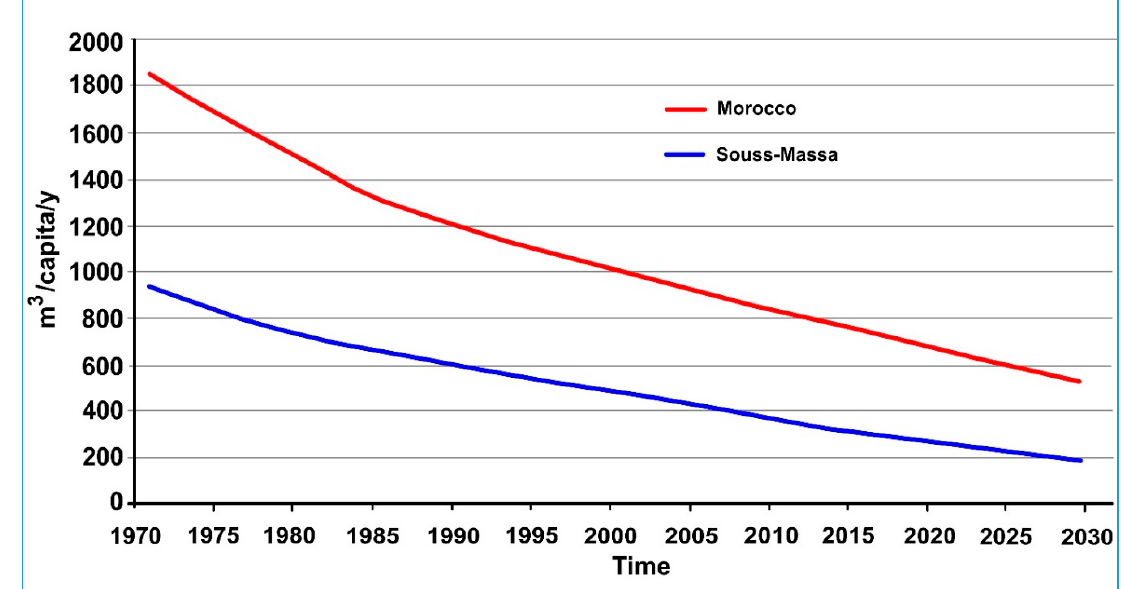
Figure 8. Monitoring and scenarios of water availability per capita in Morocco and in the Souss-Massa basin. (Adopted from [21,52]).